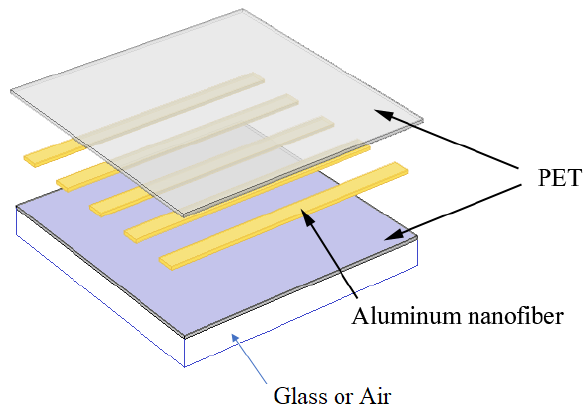
Figure 2. Proposed nanofiber film.